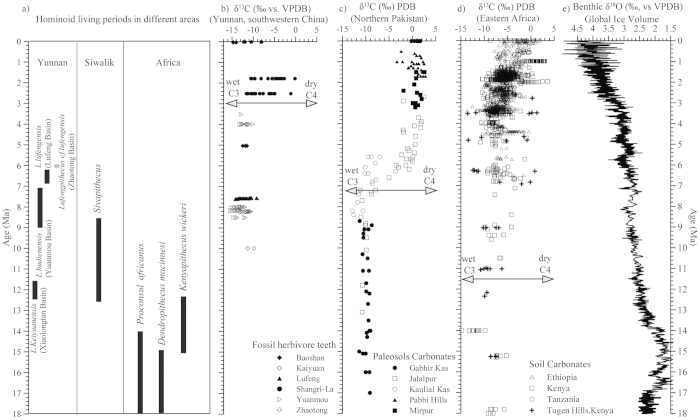
Comparison of hominoid sites in Asia and Africa.(a) Hominoid occurrences in Southeast Asia, Siwalik and Africa. Carbon isotope changes from (b) Yunnan41, (c) Siwalik in Northern Pakistan39, and (d) East Africa42. (e) Global ice volume as indicated by marine oxygen isotope43.